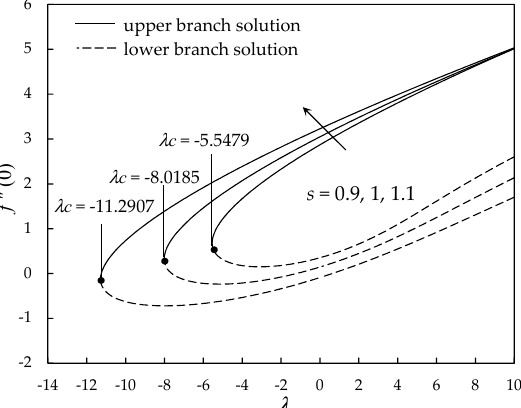
Figure 8. Variation of the reduced skin friction coefficient of f (cid:48)(cid:48) ( 0 ) with mixed convection parameter λ for various values of the suction parameter s when φ = 0.01, Nr = 0.1, K = 0.1 and c = − 1 for Cu-water nanofluid.